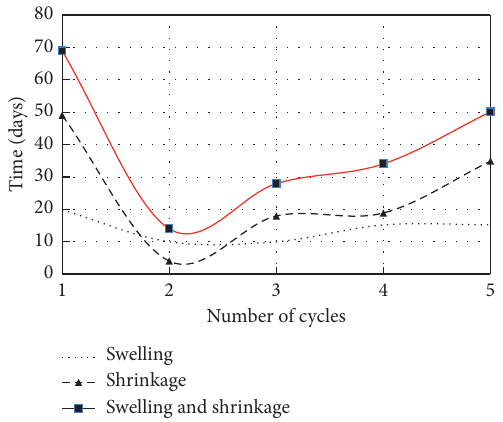
Figure 8: Time required for each stage of the cycle for UECS.